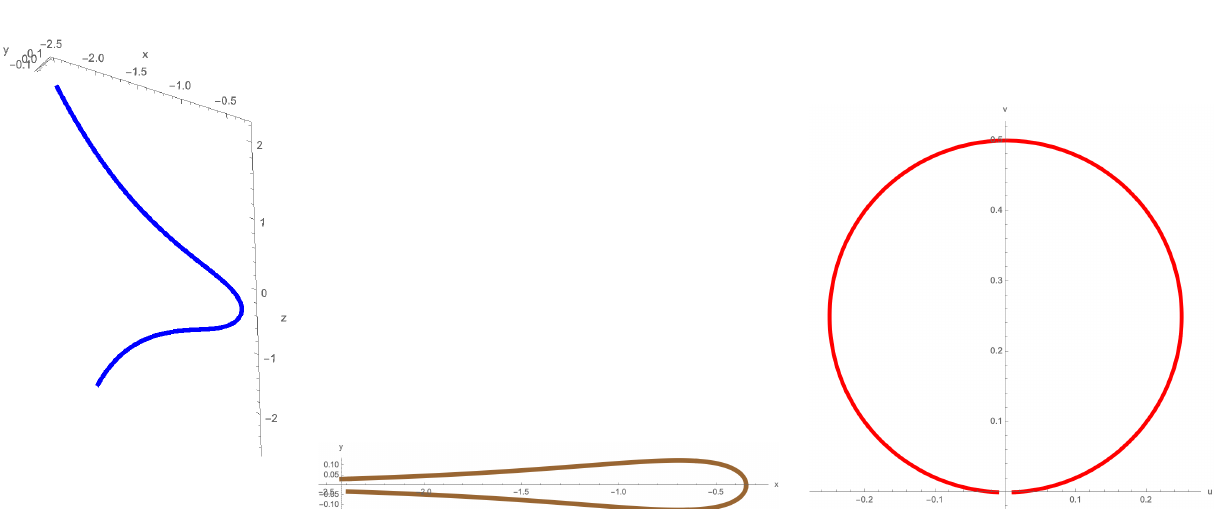
, c 0 = 0, c 1 = 0, c 2 = 0. 3